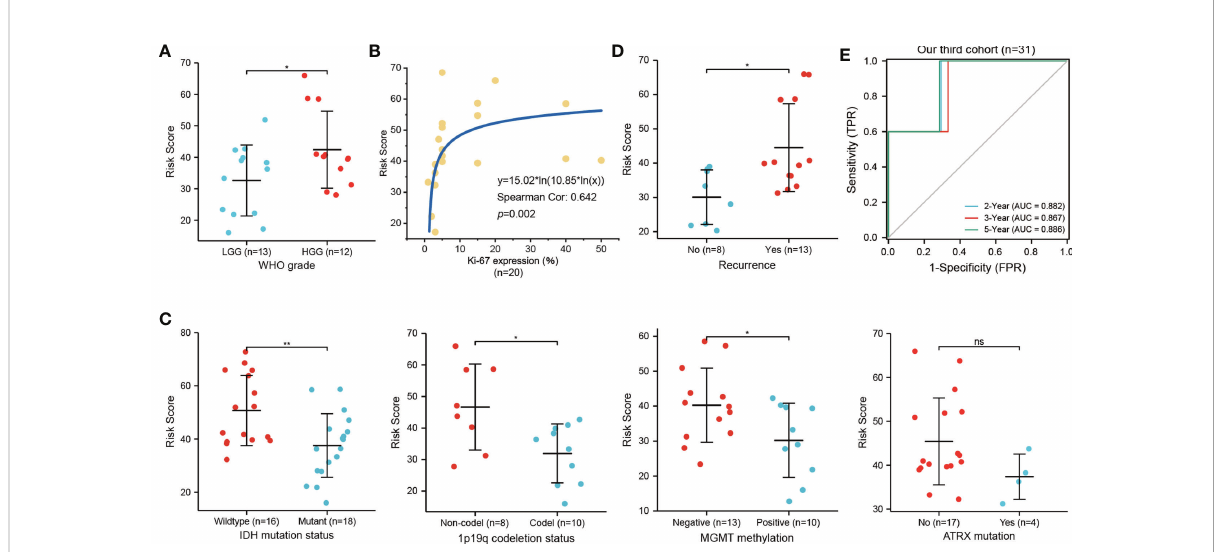
FIGURE 7 Relationship of necroptosis-related risk score and clinicopathological features in the third cohort. (A) HGG patients show a higher risk score than LGG patients (n=25). (B) Positive correlation between the Ki-67 expression and risk score (n=20). (C) High risk score was signi fi cantly related to IDH wildtype (n=34), 1p19q non-codeletion (n=18), and MGMT unmethylated (n=23) status but not to ATRX mutation (n=21). (D) Glioma patients with postoperative recurrence show higher risk scores (n=21; * p < 0.05; ** p < 0.01; ns, not signi fi cant). (E) ROC curve for predicting 2-, 3-, 5-year OS of glioma patients in our third cohort (n=31, 2 deaths and 29